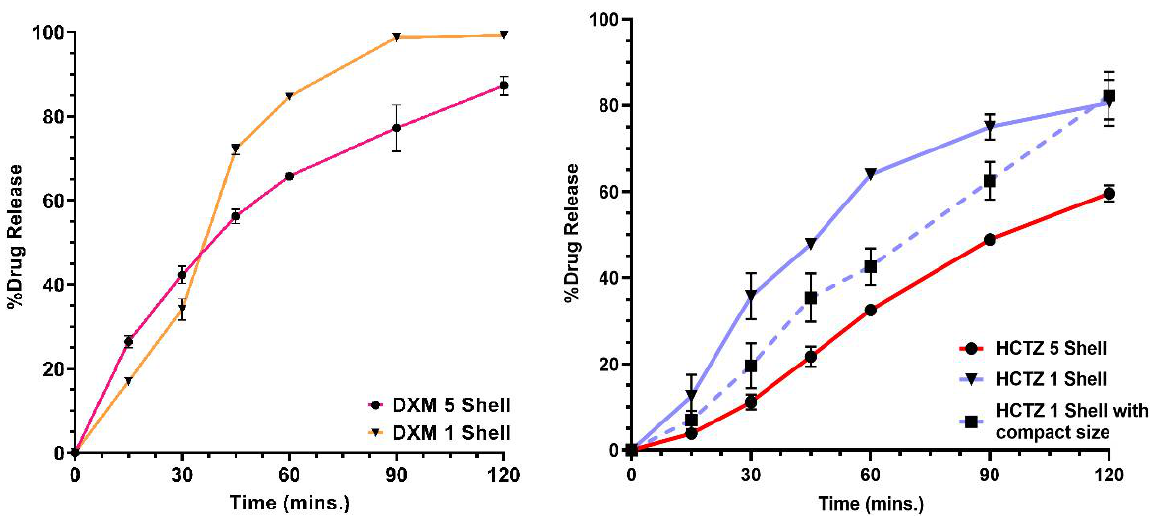
Figure 8. In vitro release of printlets in 250 mL of 0.1 N HCl. The drug release was affected by the drug, infill, size and most importantly the shell number of the printlets.